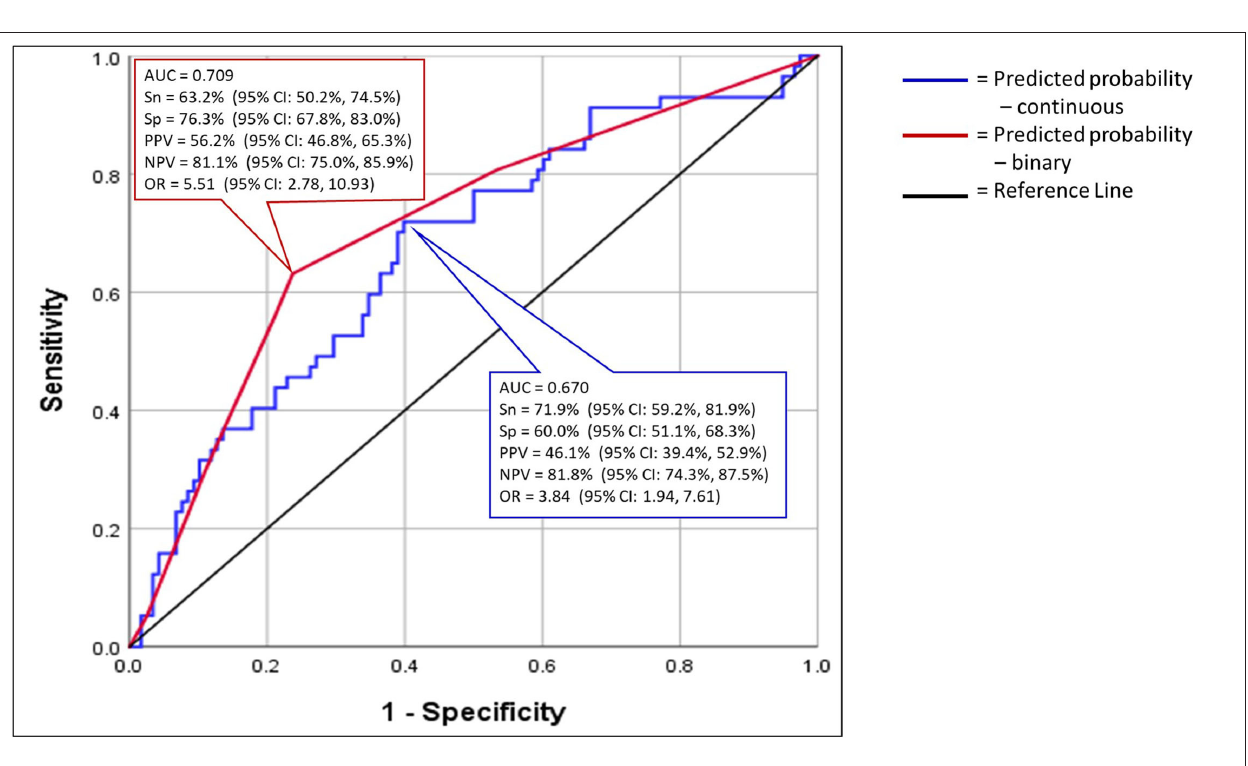
FIGURE 4 | Receiver operator characteristic analysis for the predicted probabilities of the final three variables for both the continuous and binary forms of the three